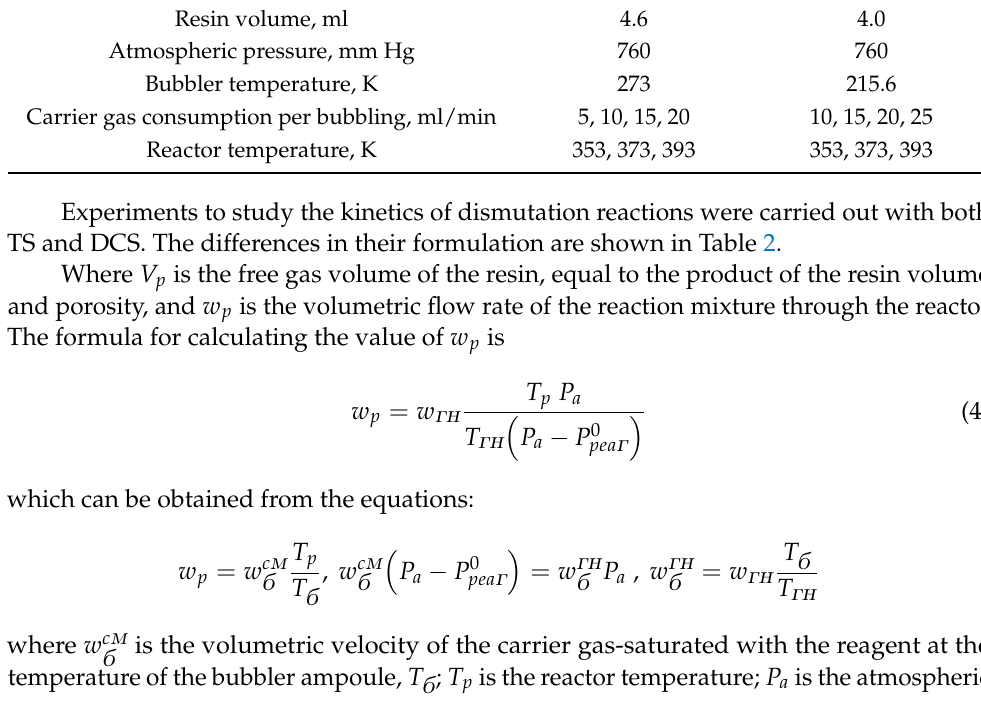
Table 1 are: (2.1 ± 0.1) · 10 − 2 and 0.35 ± 0.02 at 353 K; (2.2 ± 0.1) · 10 − 2 and 0.360 ± 0.014 at